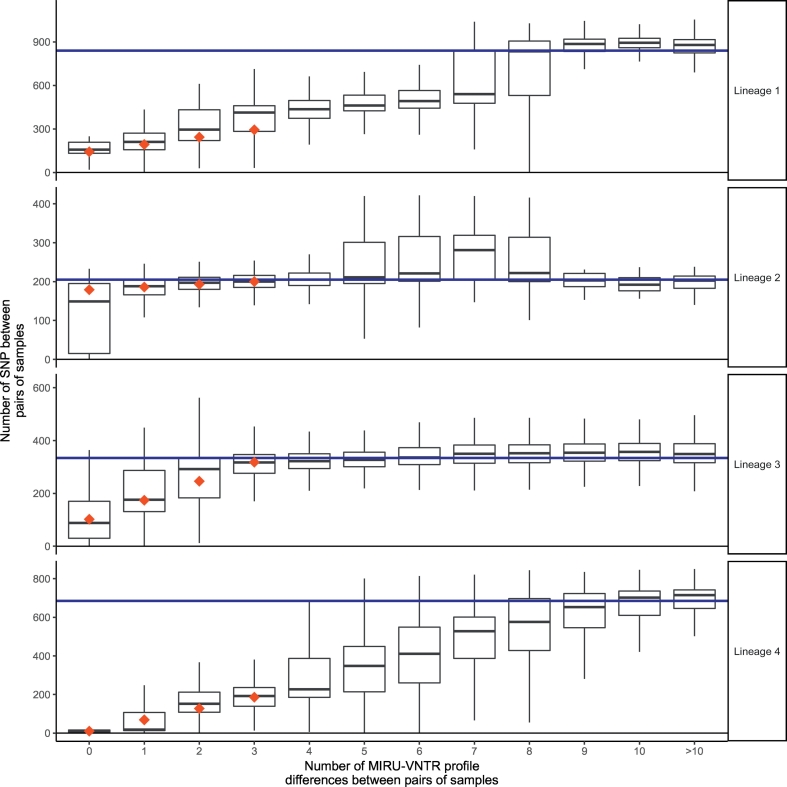
The relationship between MIRU-VNTR profile variation and SNV variation, stratified by lineage. The x-axis shown the number of MIRU-VNTR loci differing between pairs of isolates. For example, if a sample had a MIRU-VNTR profile of 131, and another 111, one locus differs, which counts as a 1 MIRU-VNTR profile repeat number change. The y-axis shows the median number of SNV in each of a large number of pairs examined. The blue line reflects the median pairwise distance within all sampled isolates of each lineage. Red dots are fitted median values from a multivariable quantile regression model relating SNV (dependent variable) to lineage, MIRU-VNTR profile difference between 0 and 5 loci, inclusive, and their interaction.